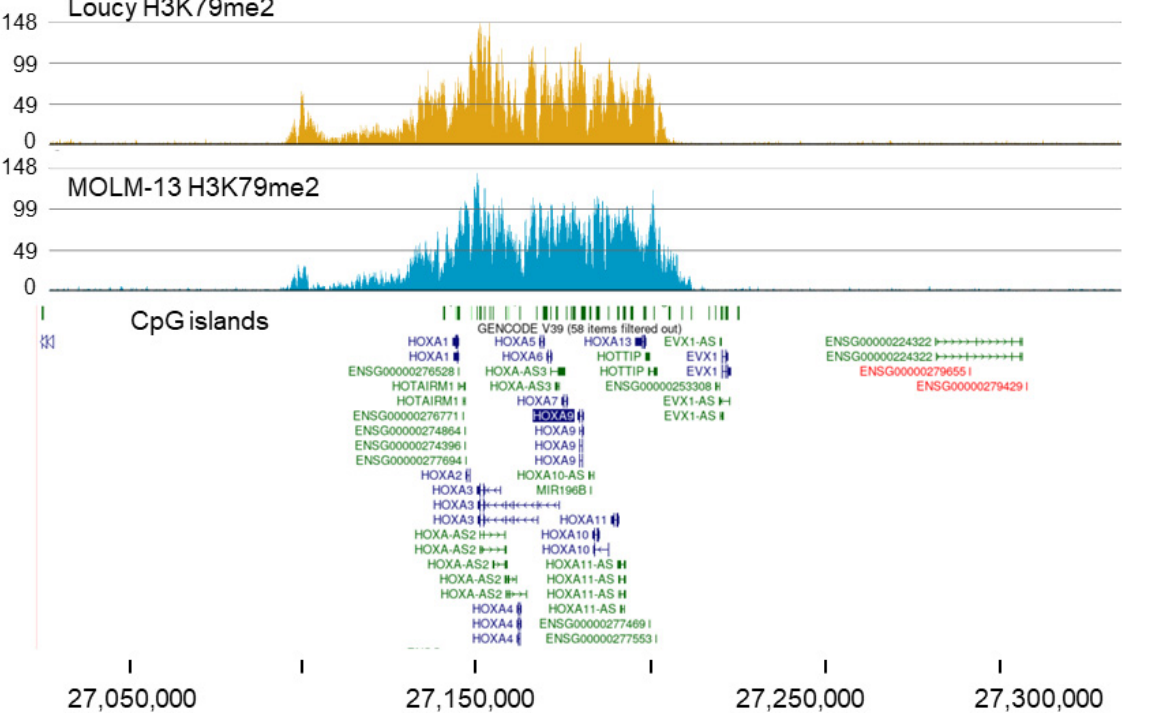
Figure 5. Broad H3K79me2 domain with the HOXA9 gene in Loucy cells. The panel shows the H3K79me2 ChIP-Seq tracks for HOXA9 in MOLM-13 and Loucy cells.